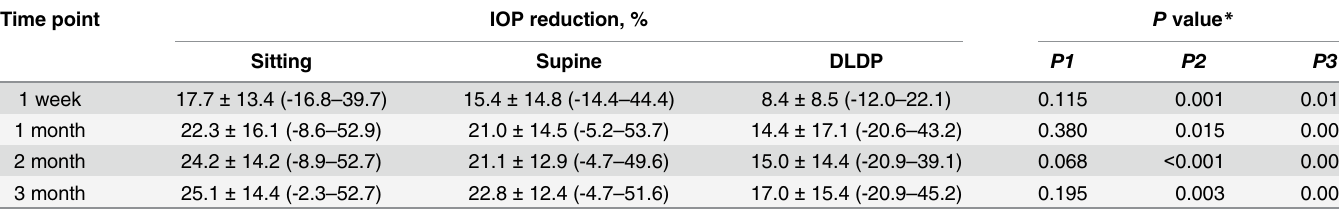
Table 2. Mean Percentage of Intraocular Pressure Reduction in the Different Body Position.